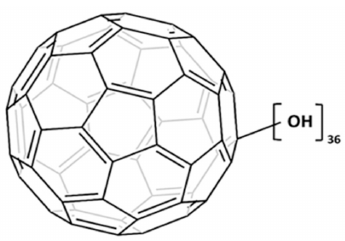
Figure 1. Illustrative graph of synthesized water-soluble fullerenol.